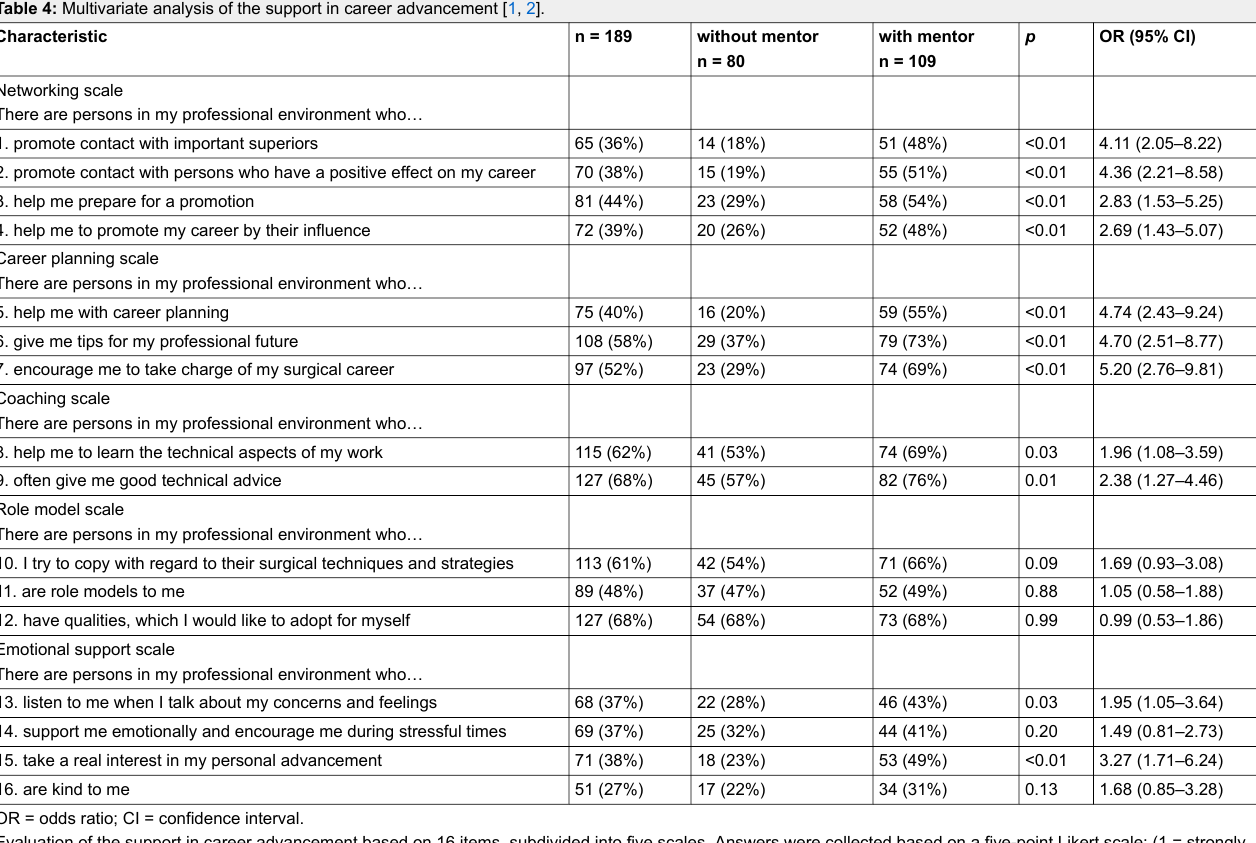
Table 4: Multivariate analysis of the support in career advancement [1, 2]. Characteristic